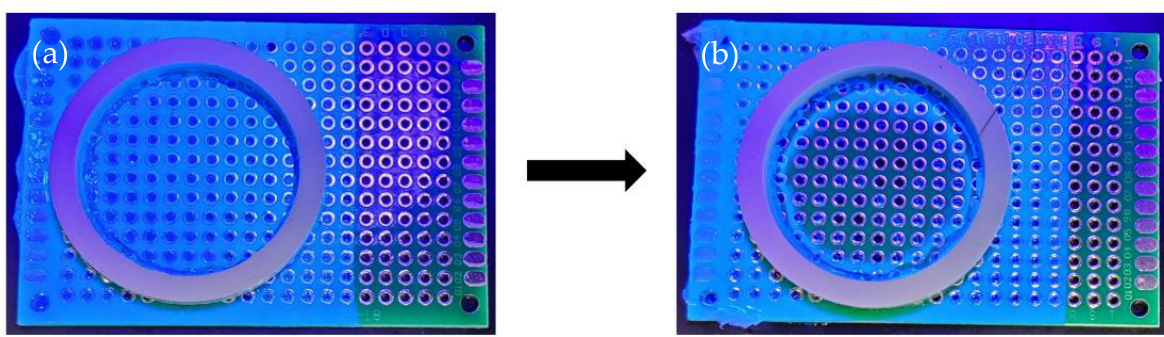
Figure 2. ( a ) Prior to dwell time test with 0% substrate exposure. ( b ) After dwell time test with 90% substrate exposure.